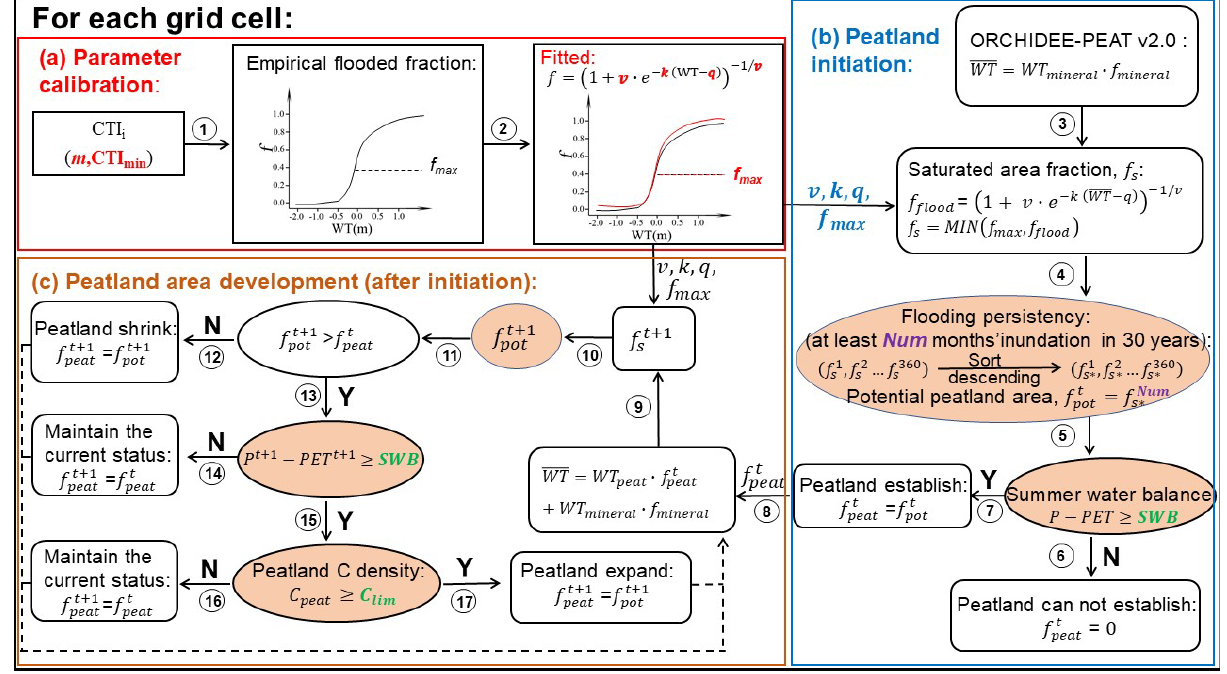
Figure 1. Information flow of dynamic peatland area module in ORCHIDEE-PEAT v2.0. Num is a grid-cell-specific parameter, and SWB and C lim are globally uniform parameters (Sect.